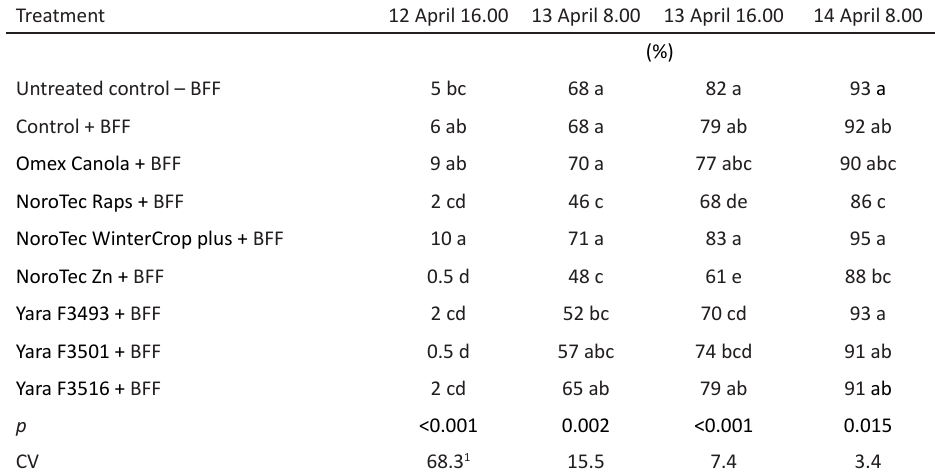
Table 5. Average emergence of spring oilseed rape (cv. Majong) in a seed vigour test at various times. Seeds were treated with mineral nutrient products applied with (+) and without (–) binder, filler and Rovral (BFF), in 2016, n=4.